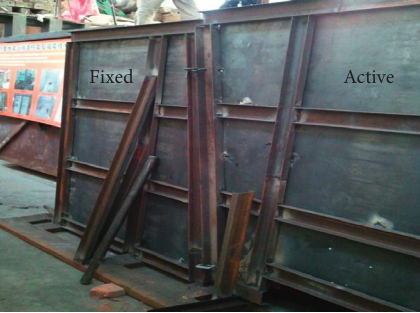
Figure 1: Stick-slip dislocation test box.